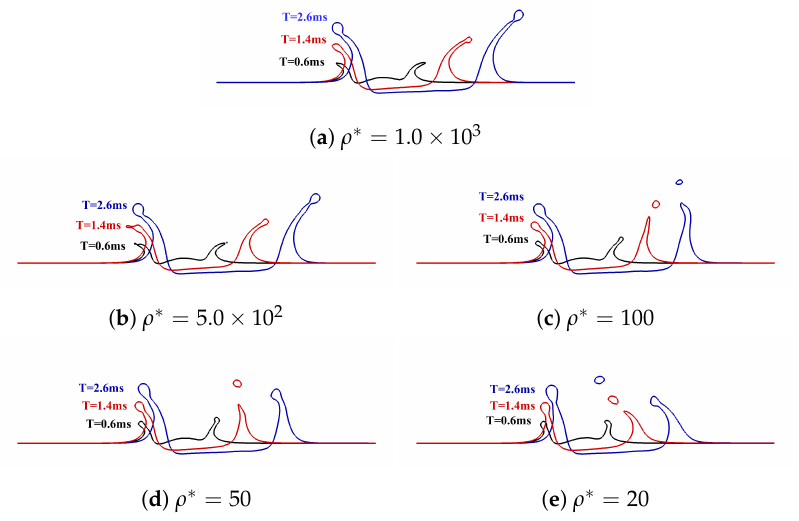
Figure 12. Interface of a drop impact upon a dynamic film at different density ratio when θ = 30 ◦